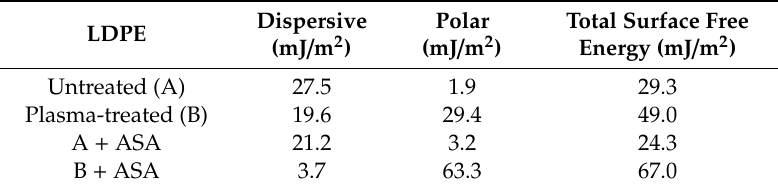
Table 2. The surface free energy of LDPE